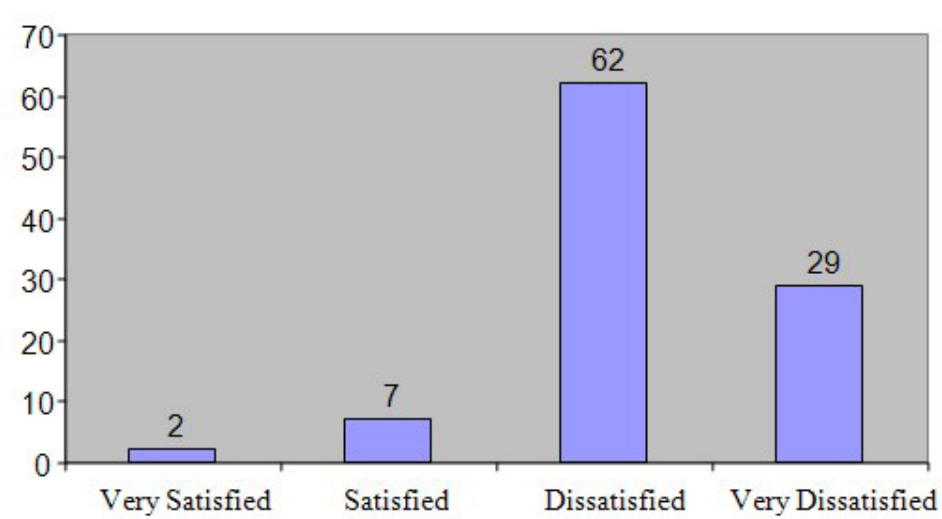
Figure 3 . Levels of satisfaction of students in